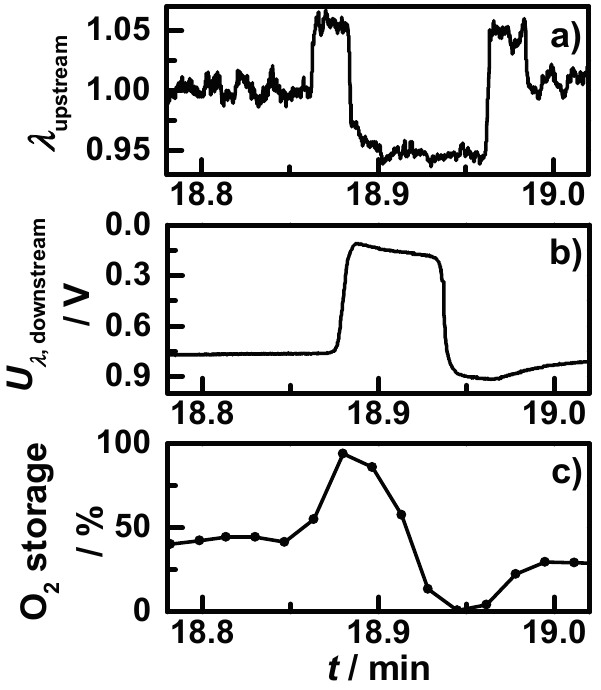
Figure 9. Section of the NEDC measurement with warm start conditions from Figure 7 showing the OSC step: ( a ) the air-fuel ratio λ measured by the upstream broadband lambda probe; ( b ) downstream lambda probe signal; and ( c ) the microwave-derived oxygen storage